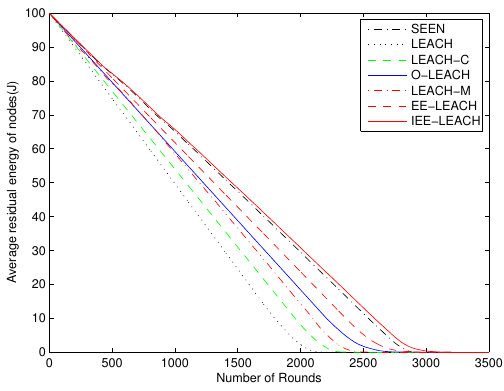
Figure 7. Comparison of residual energy of